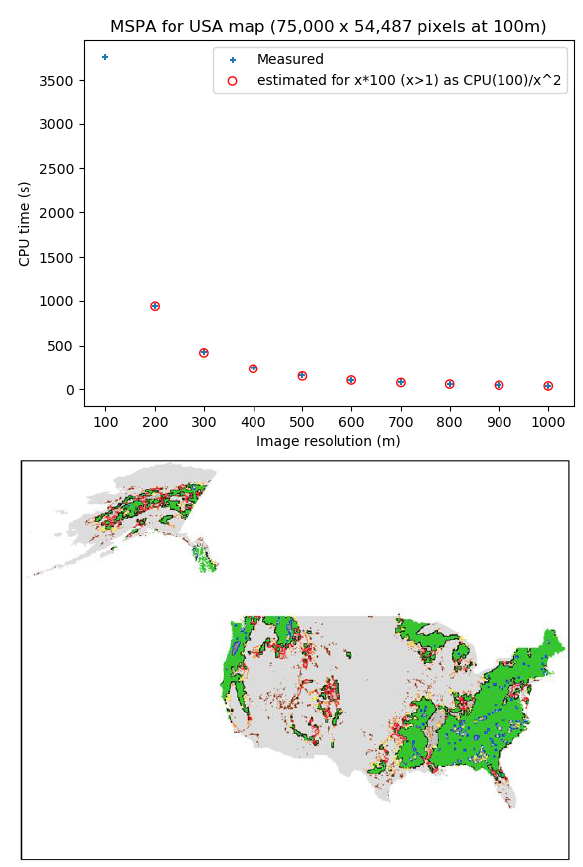
Figure 3 . Top: The CPU time of MSPA of a map of the United States of America at different resolutions shows a linear relation with respect to the number of image pixels: measured values and estimations based on measured value at 100 m divided by x 2 where x > 1 is the multiple of 100, i.e., x = 2, 3, ..., 10 . Bottom: MSPA output on the USA map resampled at 10,000 m resolution using mode